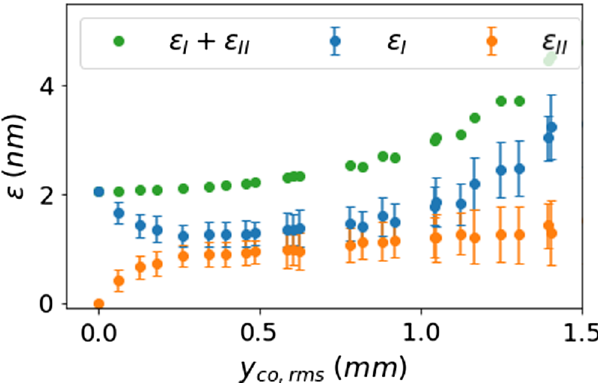
FIG. 5. Correlation between the emittances and RMS vertical orbit distortions y co;rms . With gradually increasing orbit distor- tion, a very flat beam becomes a near-round one. When the closed orbit distortion is sufficiently large, it becomes flat (and tilted) but with larger emittances. The total emittance is observed to be blown up, albeit rather where X 0 represents the 6-dimensional closed orbit vector at the magnet entrance and R , T , U are the 1st – 3rd order on- axis transport matrices which can be obtained with the truncated power series algorithm [28]. However, the trun- cated map is usually not perfectly symplectic, and can